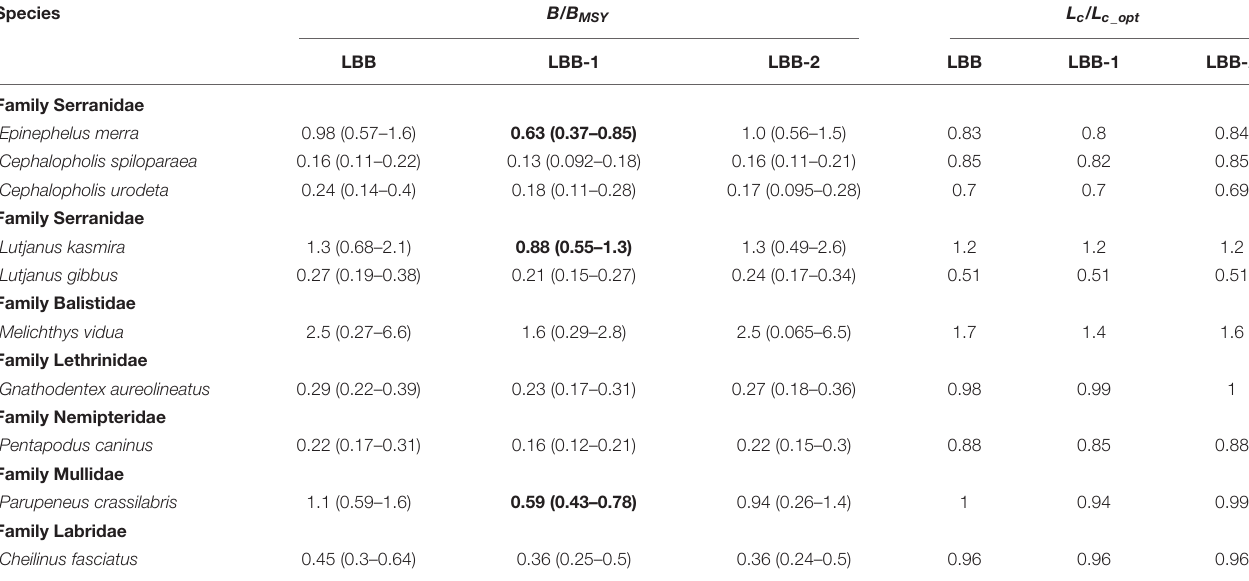
TABLE 5 | Performance comparison of three length-based methods for the 10 coral reef fish species in Nansha Islands, South China Sea. Species B / B